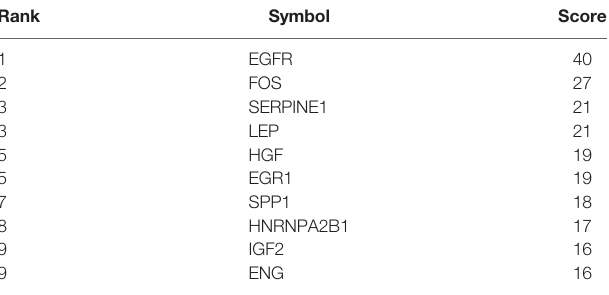
TABLE 6 | The top 10 genes in the network are ranked in order of degree.